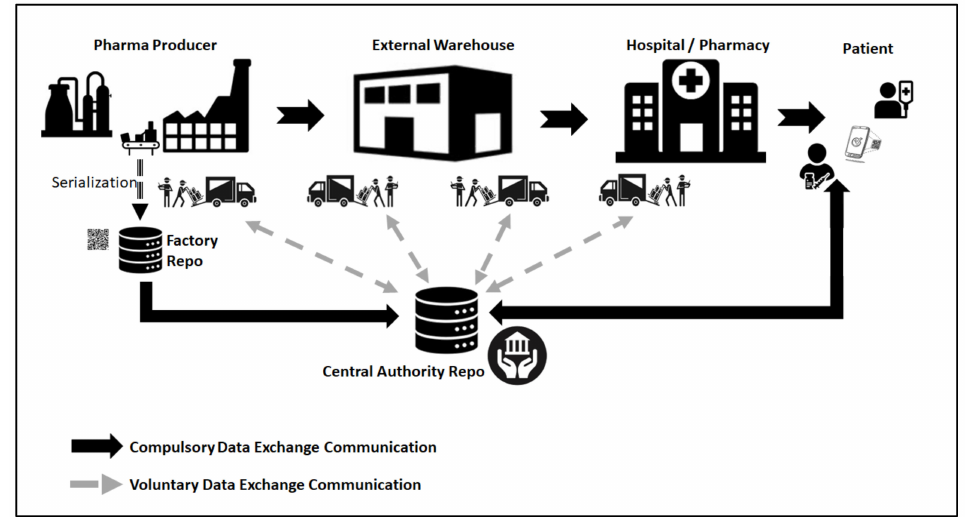
Figure 1. Track and trace process with a central